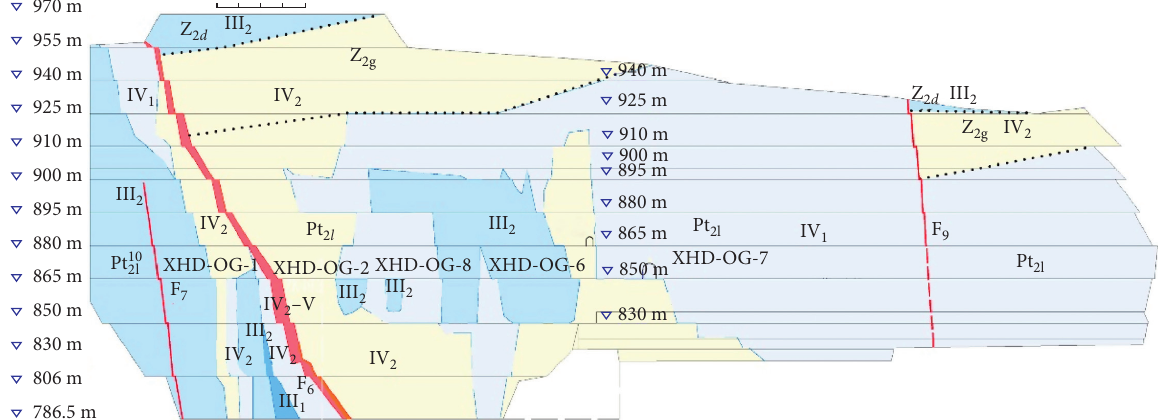
Figure 13: Distribution map of main